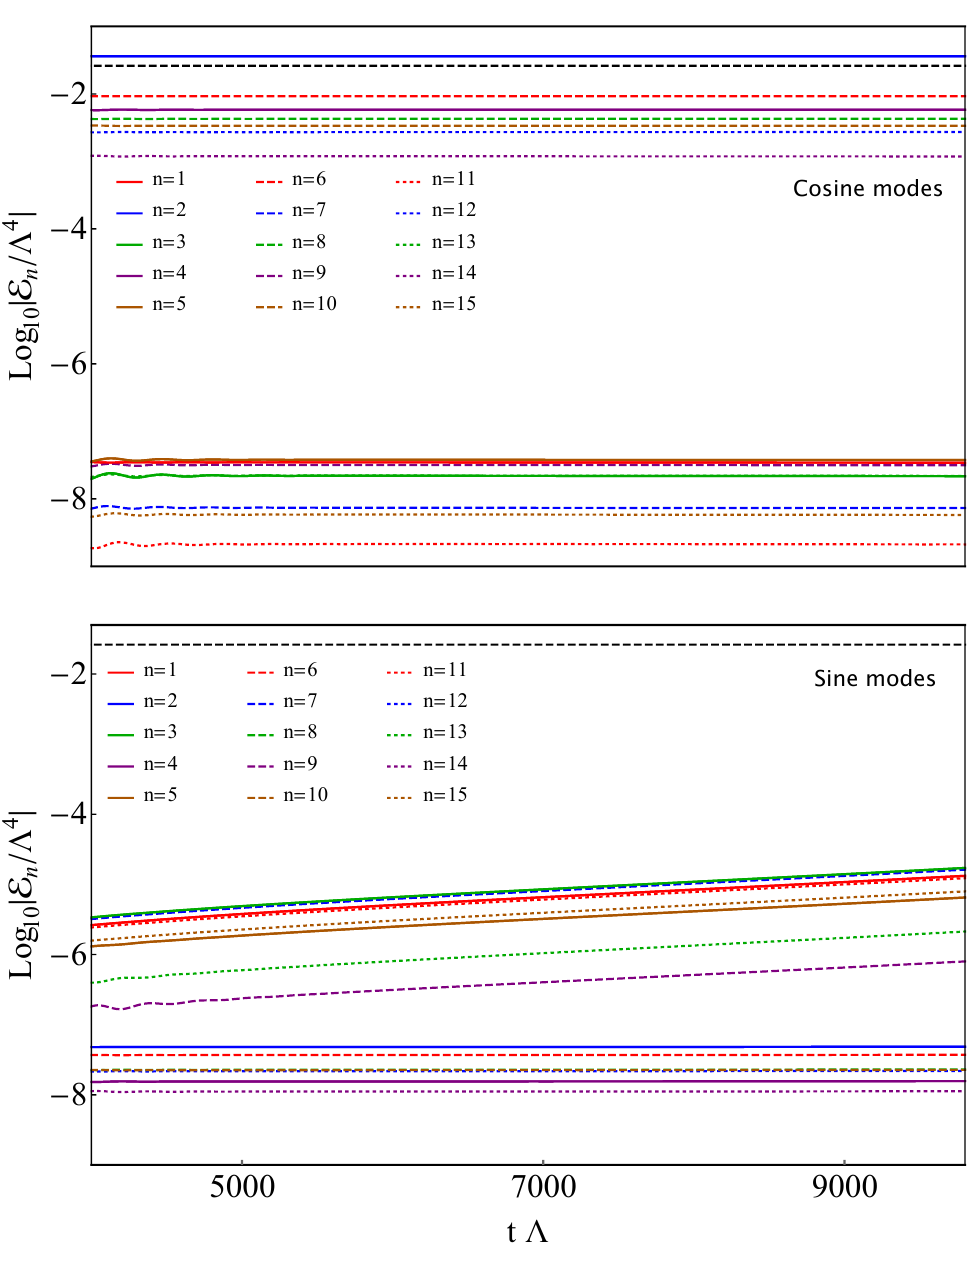
Figure 17 . Late time evolution of some Fourier modes of the energy density shown in (cid:12)g- ure 16(right). The black, dashed horizontal lines at the top indicate the average energy density or, equivalently, the n = 0, constant mode.